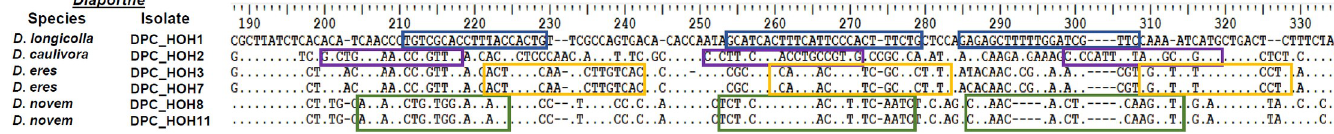
Fig 1. Primer and probe specificity based on alignment. Position of primer-probe combinations DPCL (blue frames), DPCC (purple frames), DPCE (orange frames), and DPCN (green frames) in the alignment of TEF sequences of Diaporthe species. Identical nucleotides and gaps are represented by dots and dashes, respectively. The sequences in the alignment were chosen from the sequences obtained in [4] in order to represent all intra specific polymorphisms, identical sequences were removed.